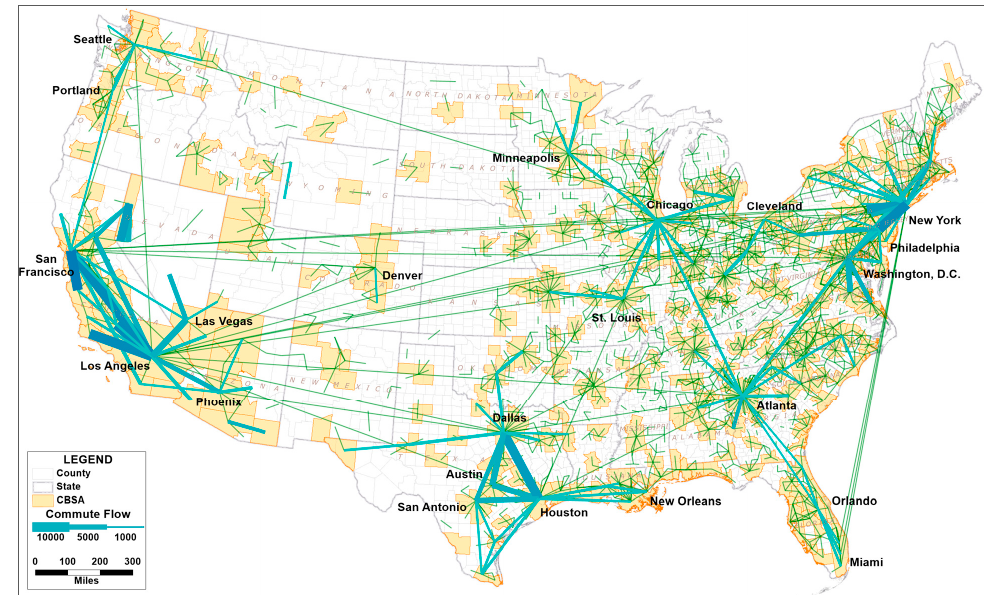
Figure 2. County-to-County Commute Flows in the Contiguous United